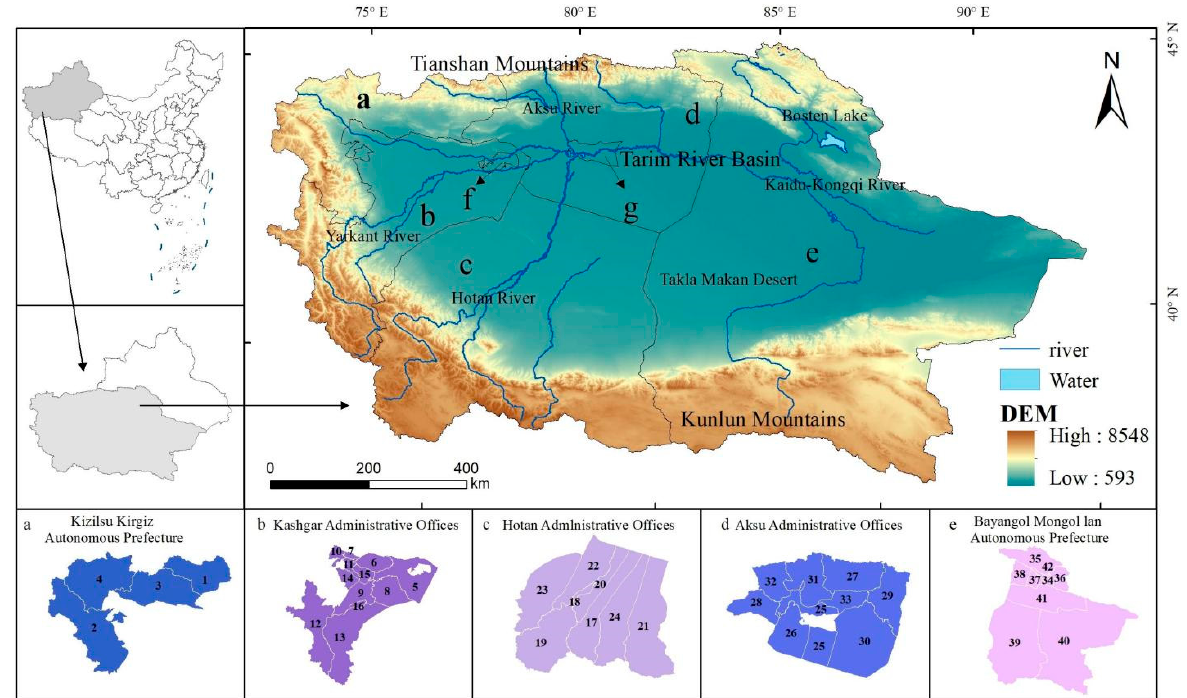
Figure 1. Sketch map of study area. Note: ( a ): Kizilsu Kirghiz Autonomous Prefecture (1: